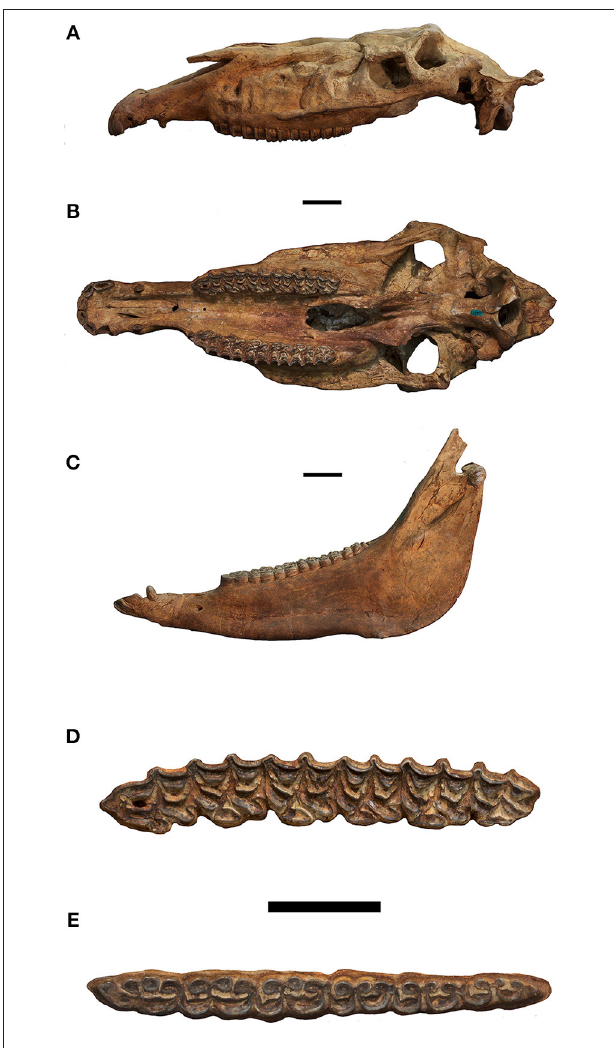
FIGURE 3 | Equus simplicidens . (A) Skull in lateral view; (B) Skull in ventral view; (C) Mandible in lateral view; (D) Upper tooth row in occlusal view; (E) Lower tooth row in occlusal